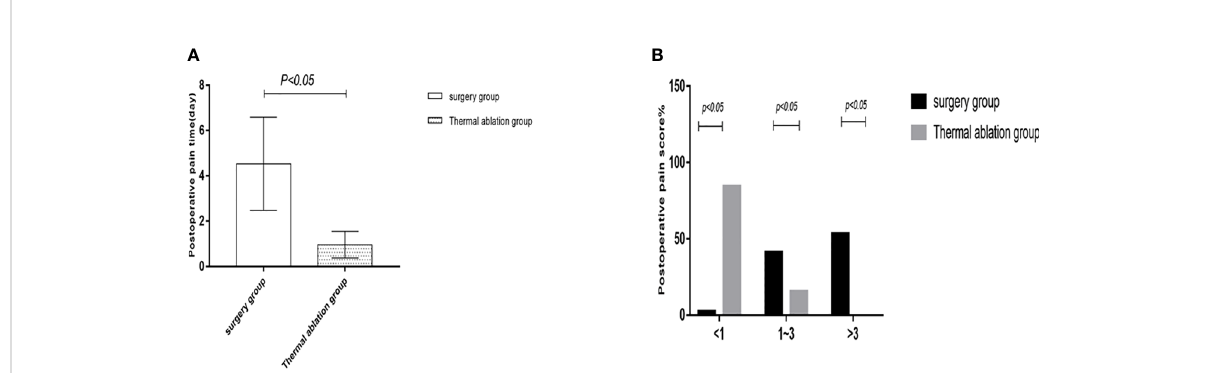
FIGURE 4 Statistical chart of postoperative pain time and a degree in two groups. (A) Statistical chart of postoperative pain time. (B) Statistical chart of postoperative pain